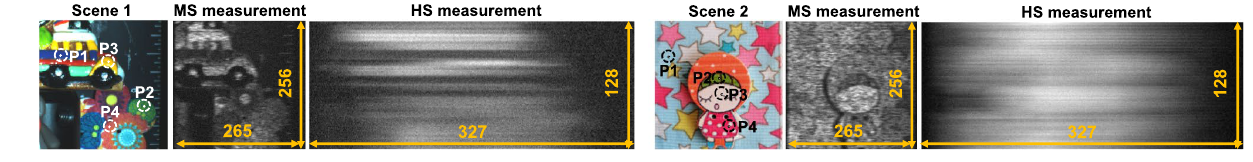
Figure 4. Target scenes and compressed measurements. Two target scenes are used to test the capabilities of the proposed system. ( a ) Scene 1. ( b ) Scene 2. The MS compressed measurements have size 256 × 265 , whereas the HS compressed measurements have size 128 × 327 . Spectral regions of interest are highlighted as P1–P4 in both color